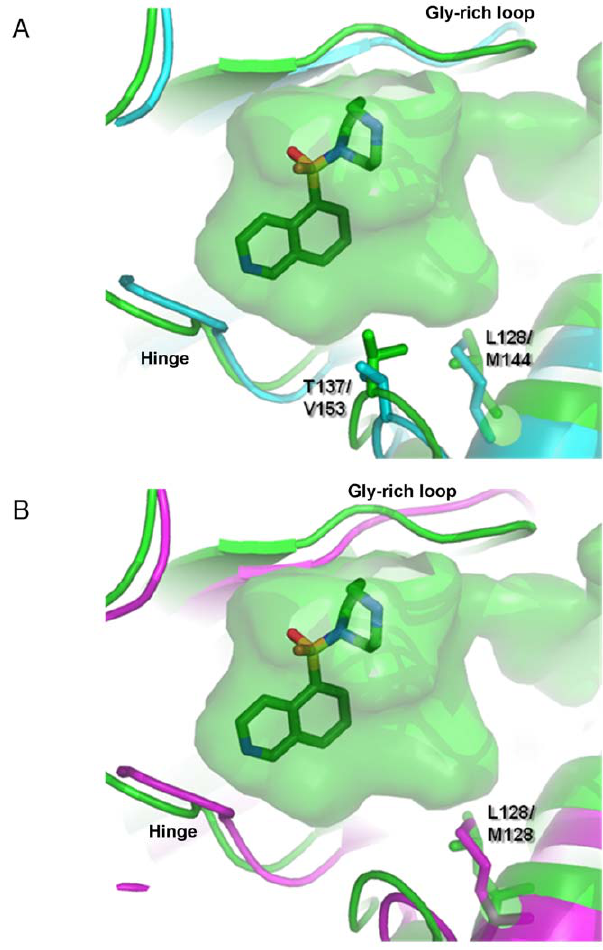
Figure 7. An overlay of MRCK b (green) with ROCK2 (A; cyan) and ROCK1 (B; magenta) highlights the very subtle structural differences that could be exploited in developing specific inhibitors. The surface shown is the nucleotide binding cavity of MRCK b , with Fasudil bound at the ATP binding site. Apart from the highlighted residues, the ATP binding sites of the three kinases are identical at sequence level.